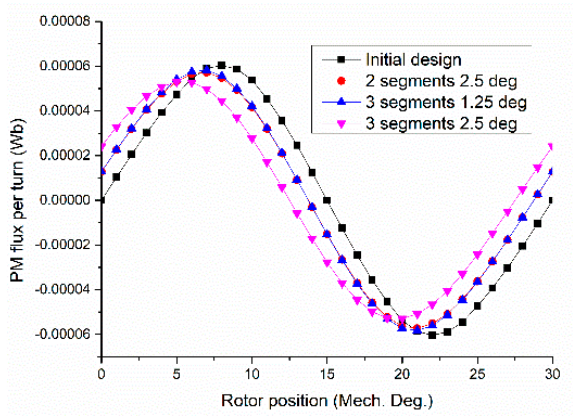
Figure 16. PM flux per turn with different machine designs.